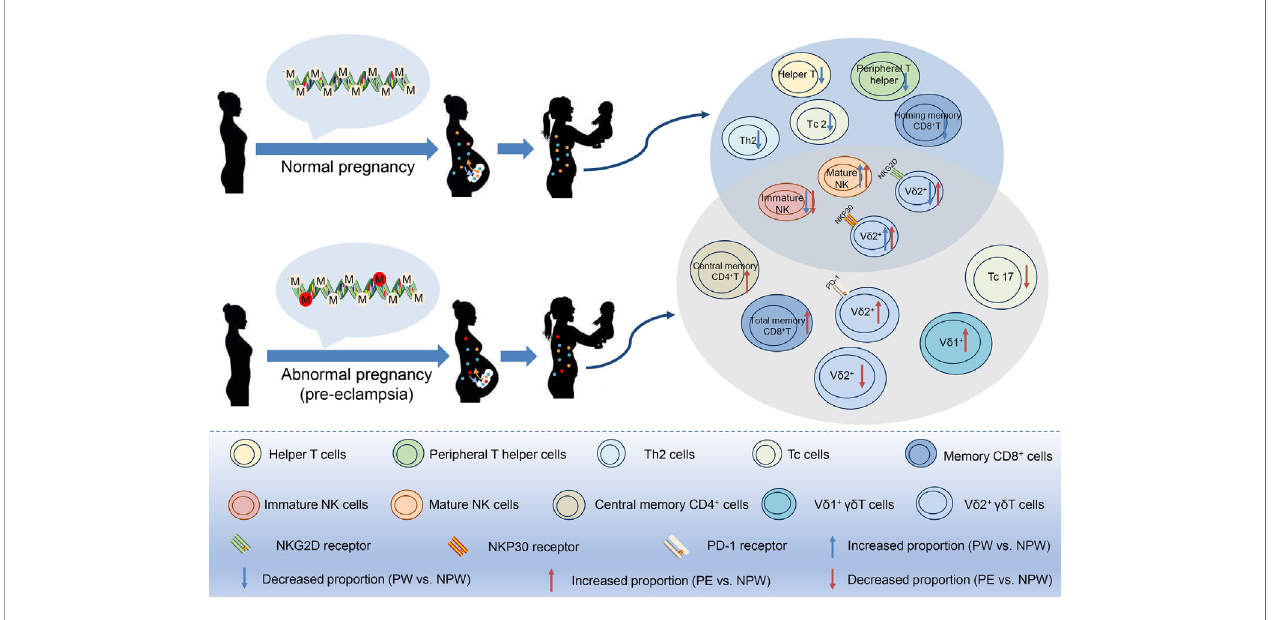
FIGURE 8 | Pregnancy-mediated DNA methylation modi fi cation may contribute to the long-term impact of normal and abnormal pregnancies on maternal peripheral immune cell subsets. In normal or preeclamptic pregnancies that resulted in the birth of a healthy baby, methylation modi fi cations in peripheral immune cells were different and persisted at least one year postpartum, as well as did differences in the immune cell subsets including T, NK and gd T cell subsets. Therefore, we speculate that pregnancy-induced differential methylation of genes in peripheral blood may be related to the altered proportion of immune cell subsets. Red circles in DNA: epigenetic changes in abnormal